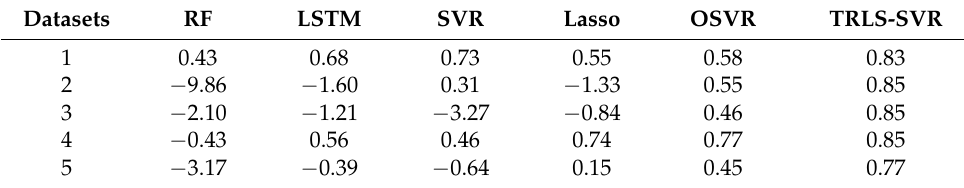
Table 2. R 2 of different methods in five datasets.